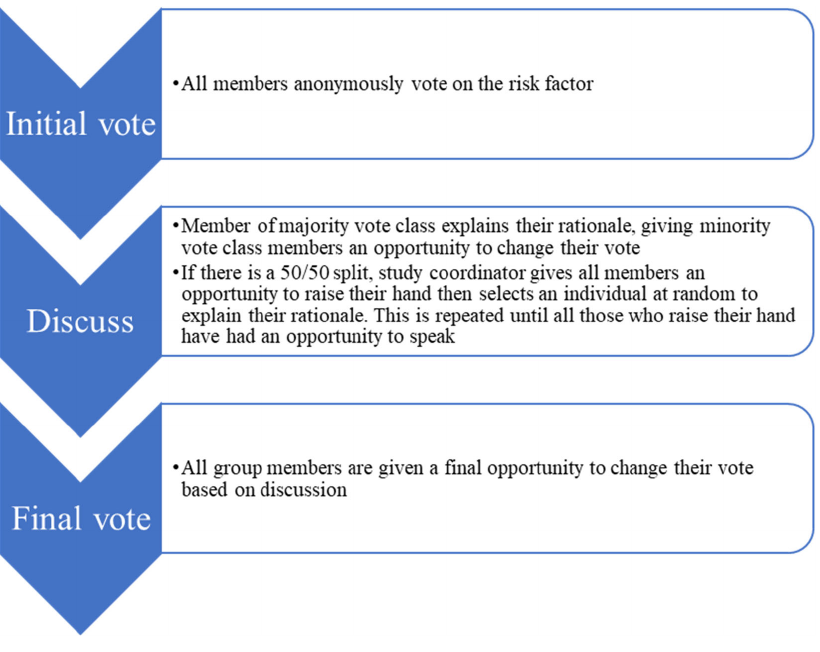
Figure 1. Focus group flow chart. This process is repeated for each risk factor included for discus ‐ sion.